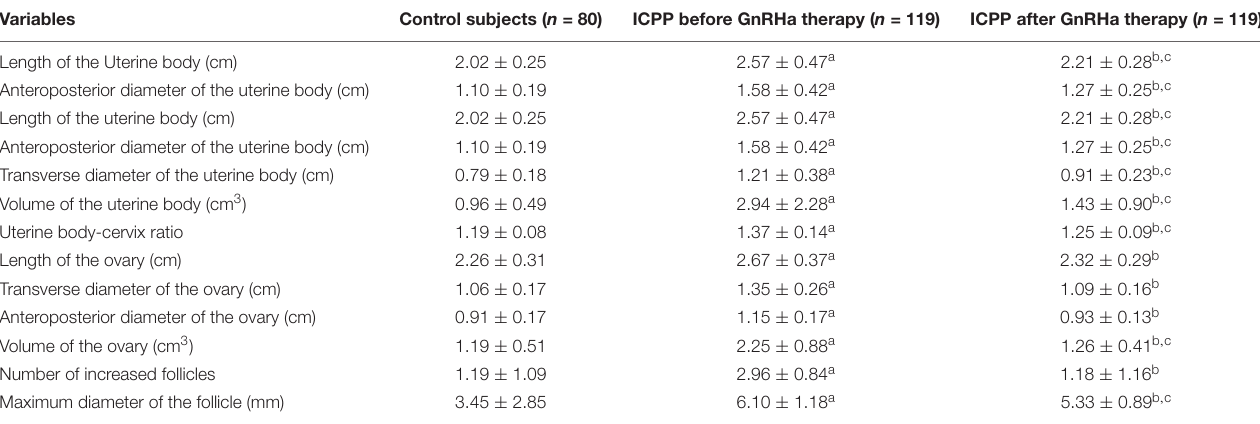
TABLE 1 | Comparisons of demographic data among ICPP patients before GnRHa therapy, ICPP patients after GnRHa therapy and normal controls.